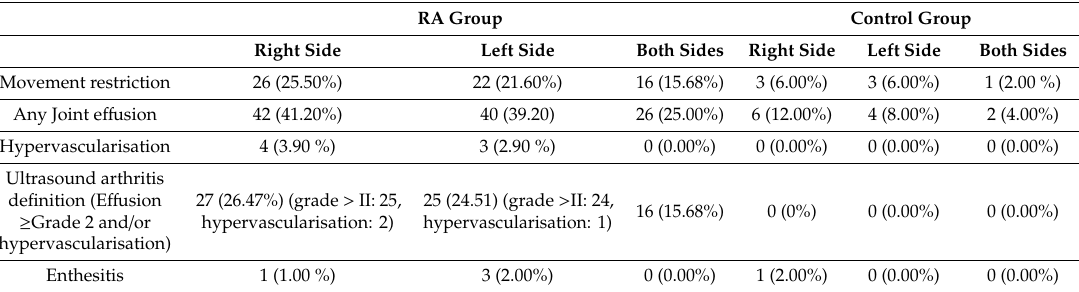
Table 2. Clinical examination and ultrasound results.